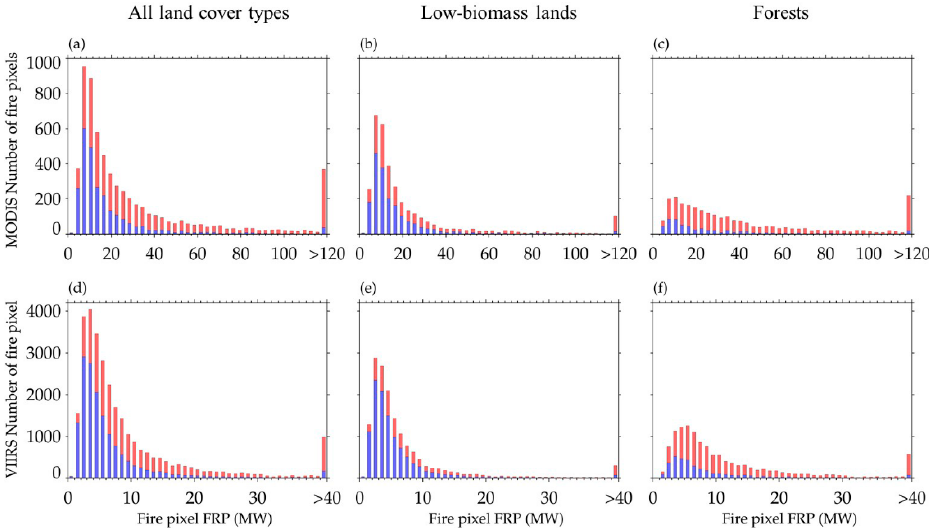
Figure 5. Number of fire pixels detected (red) and undetected (blue) by Landsat 30-m burned area along with fire pixel FRP. ( a – c ) results of MODIS fire detections over the broad cover categories of all land-cover types, low-biomass lands; and forests, respectively. ( d – f ) are same as that of ( a – c ) but for the VIIRS fire